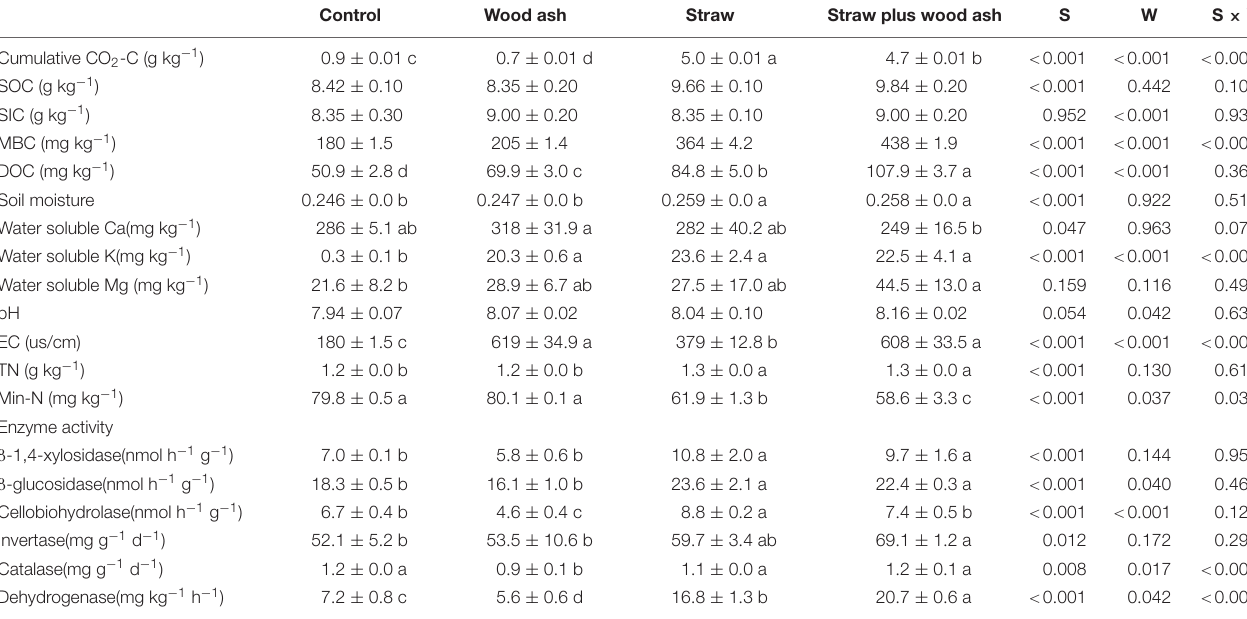
TABLE 2 | Effects of wood ash, maize straw residue, and their interaction on soil chemical characteristics and enzyme activity after 118 days of incubation. Control Wood ash Straw Straw plus wood ash S W S × W